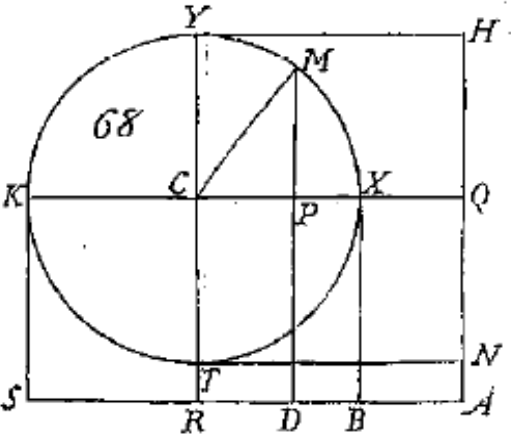
Figure 3. Graphic representation accompanying Qüestion I. Source: Verdejo [59] (plate IV).